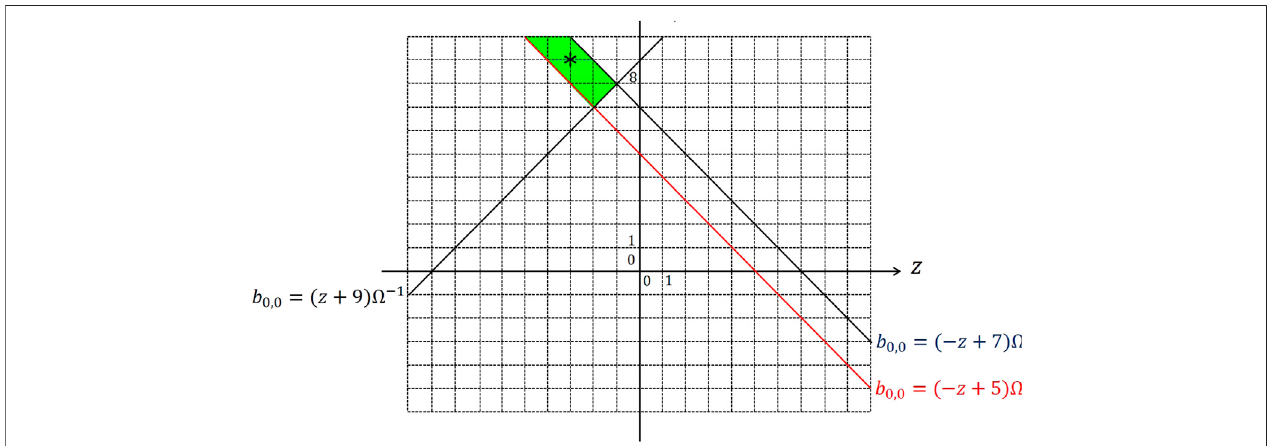
FIGURE7| Illustrationofthegeometricalanalysisadoptedtosolvethethreeinequalities Eqs.15 – 17 ,derivedthroughtheclassicalCNNdesignmethod(ItohandChua, 2003)tosynthesizeasuitablegeneforacellulararray,intendedtoextractedgesfromagiveninputbinaryimage,andreducingto b 0 , 0 > ( z + 9 ) Ω − 1 , b 0 , 0 < (− z + 7 ) Ω − 1 ,and b 0 , 0 > (− z + 5 ) Ω − 1 , respectively, under the parameter setting reported in the caption of Figure 5B . The set of admissible solutions are enclosed within the green area. The asterisk symbol, located at ( z * , b